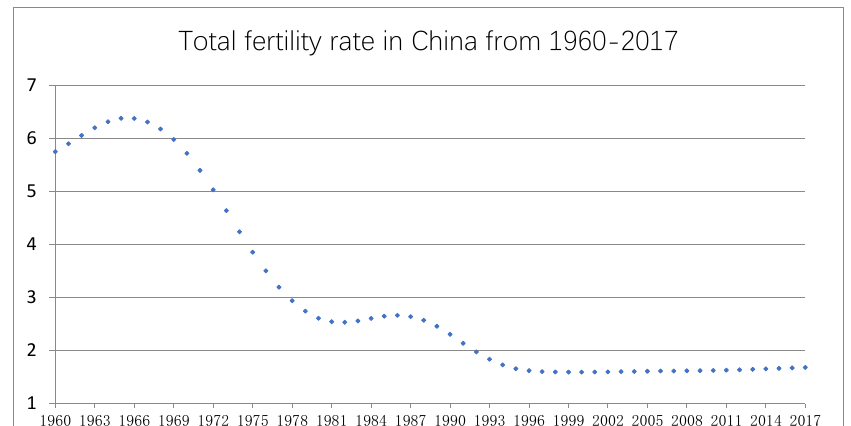
Figure 2. Total fertility rates in China for the period 1960–2017.